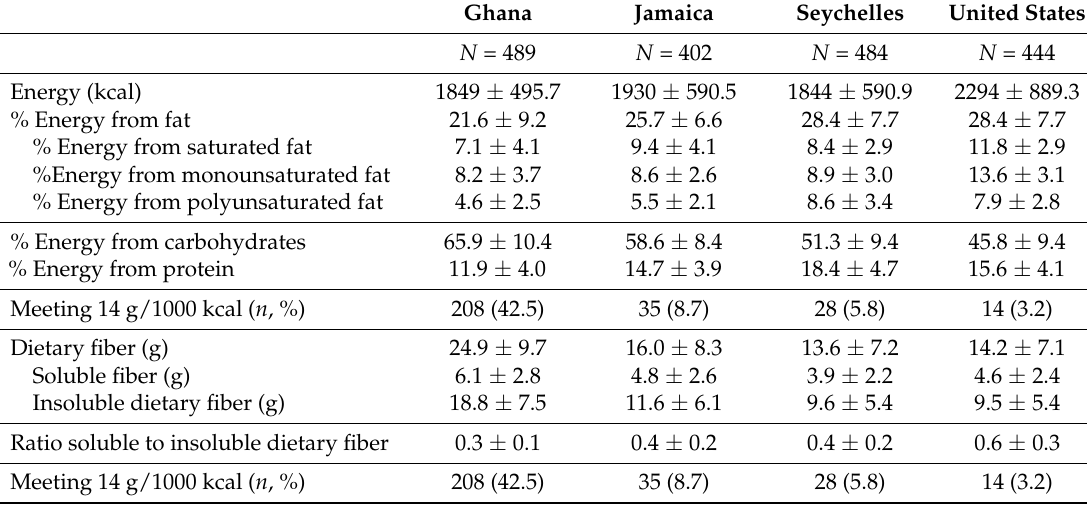
Table 2. Dietary analysis of study population by